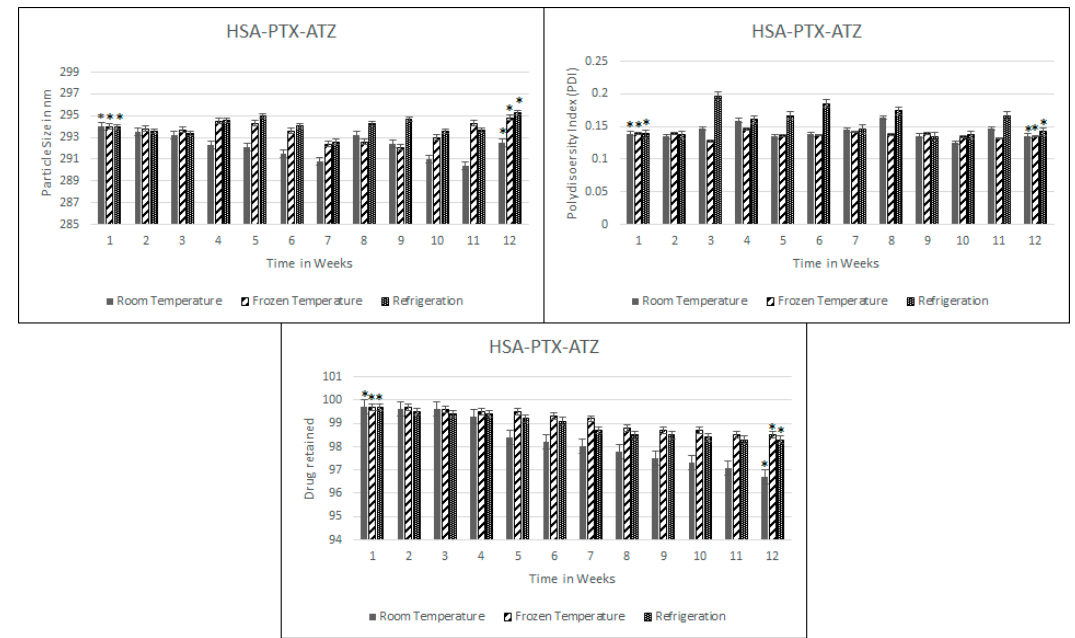
Figure 3. Stability studies over a period of 12 weeks for the hypoxia targeting drug delivery system HSA-PTX-ATZ. * Statistically not significant.